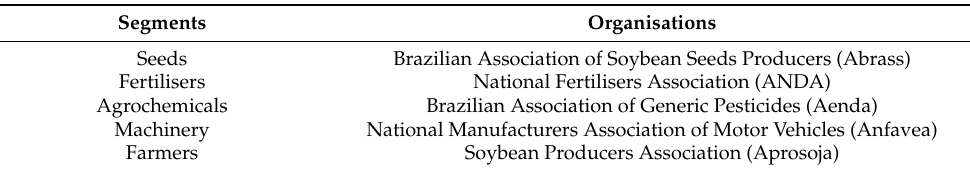
Table 1. Segments and